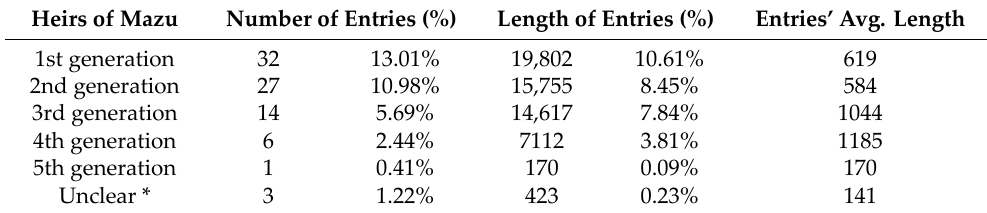
Table 6. Generations of successors to Mazu in the ZTJ